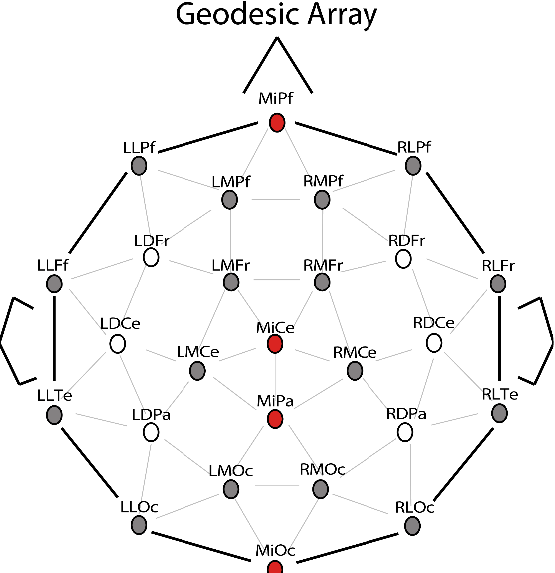
Figure 2. Layout of electrode channels used in all recordings, oriented with the front of the head at the top of the figure. Grey circles indicate electrodes utilized in distributional analyses. Red circles indicate representative midline electrodes used across all subsequent figures for visualization of ERP effects.